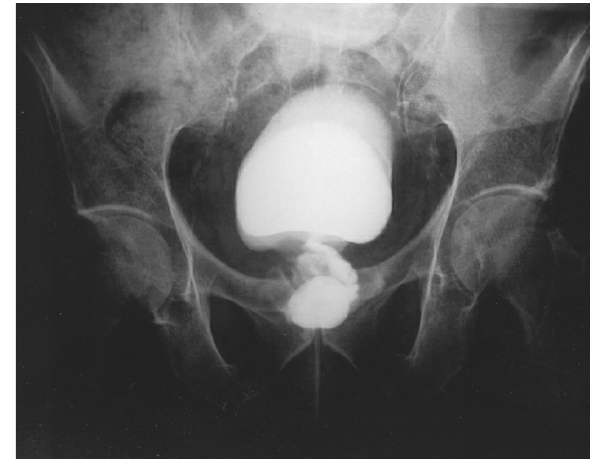
Figure 2 - Percutaneous drainage of hematoma, guided by com- puterized tomography.